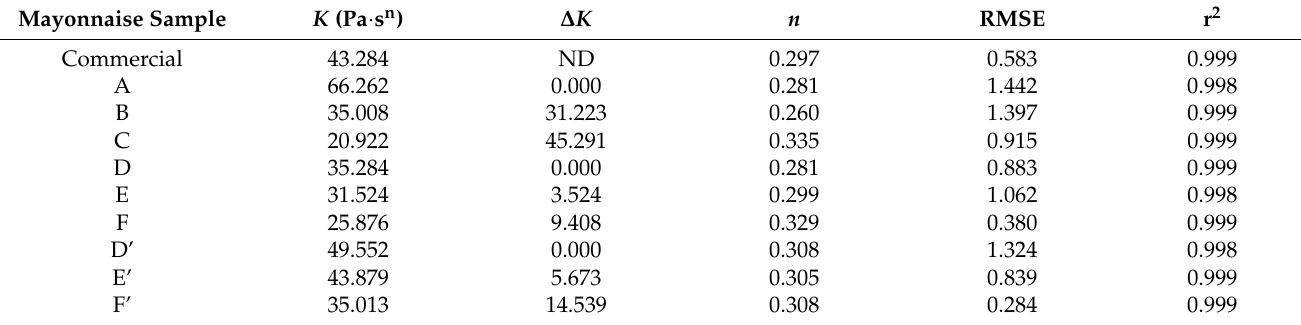
Table 2. Rheological behavior of low-fat mayonnaise samples using different oil concentrations